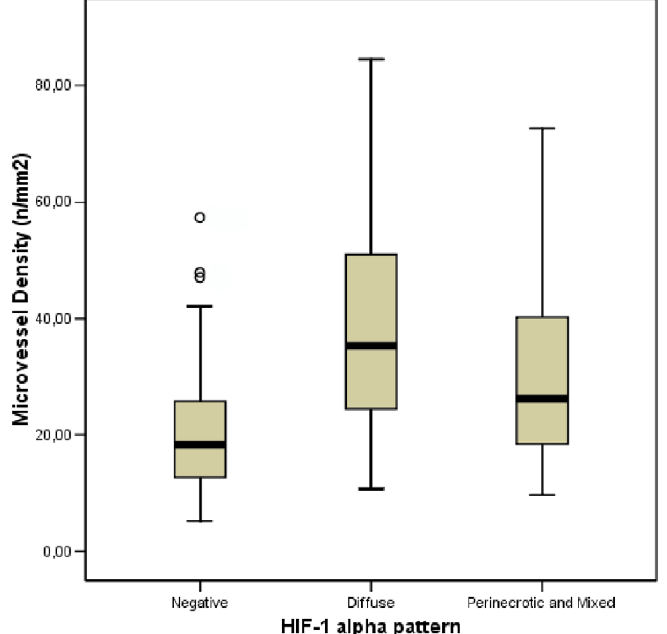
Fig. 2. Microvessel Density (MVD) for different expression patterns of HIF-1 α . Diffuse expression of HIF-1 α was associated with highest MVD; perinecrotic and mixed patterns were associated with an intermediate MVD (Kruskal–Wallis test, p < 0 .